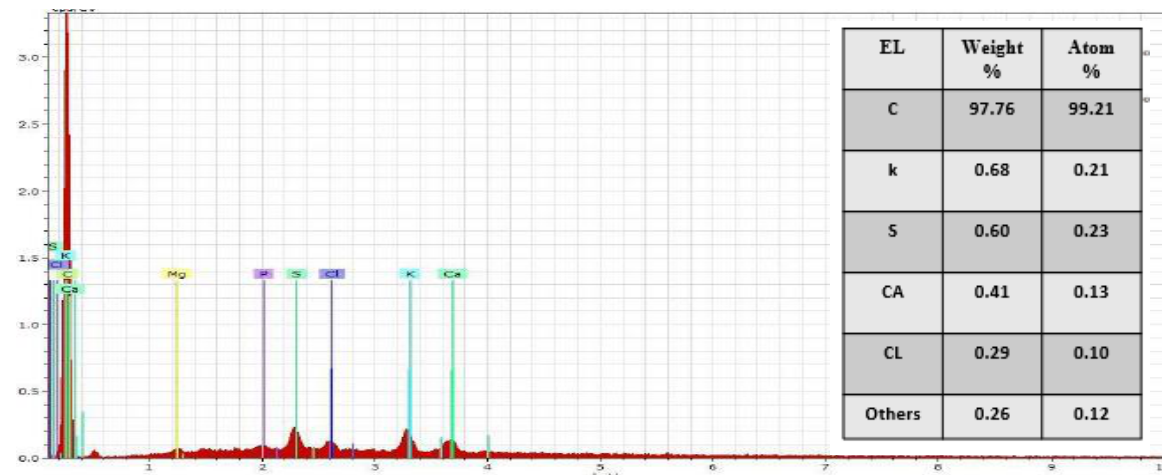
Fig. 2. EDS analysis of Alhagi.